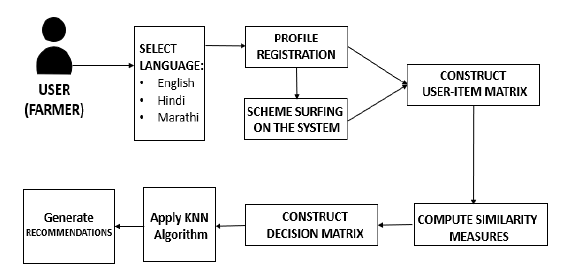
Figure 1. Block Diagram of